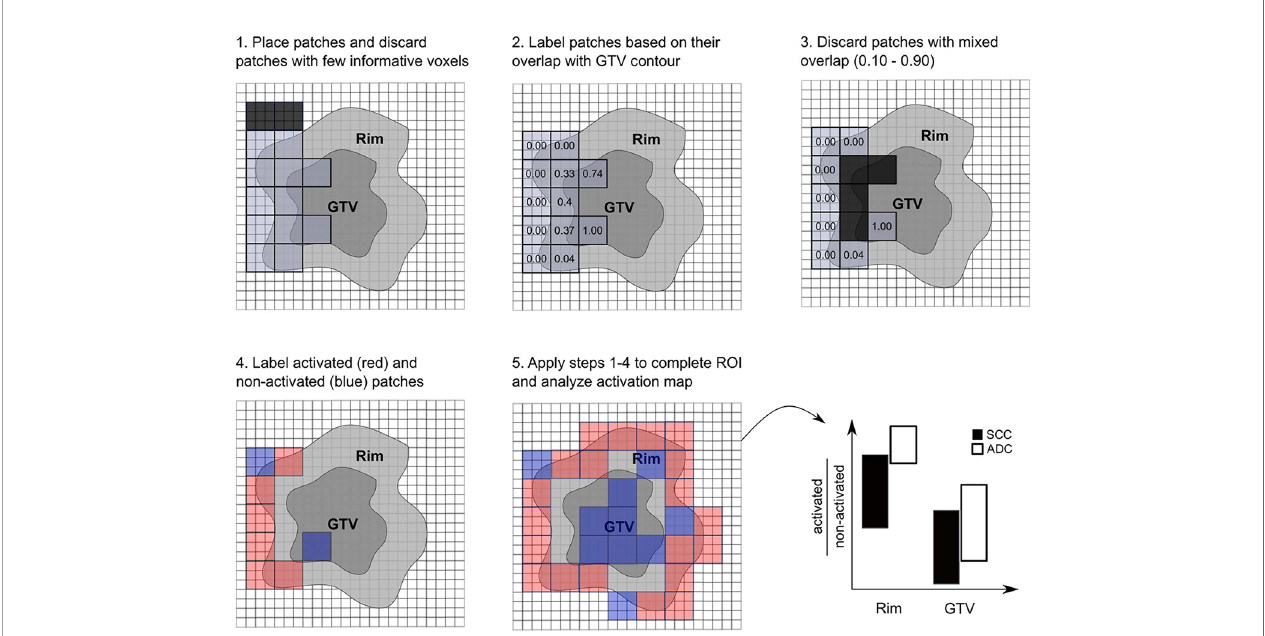
FIGURE 2 | Scheme of radiomics feature activation map creation. Patches were optimally placed and patches with few informative voxels (< 9) were discarded (1), patches were labeled according to their overlap with the gross tumor volume (GTV) contour (2), and patches with mixed overlap were discarded (3). Patches were labeled activated (red) if their feature value was larger than the global median and were labeled non-activated (blue) if their feature value was smaller than the global median. The activation ratio was analyzed per region and histological subtype